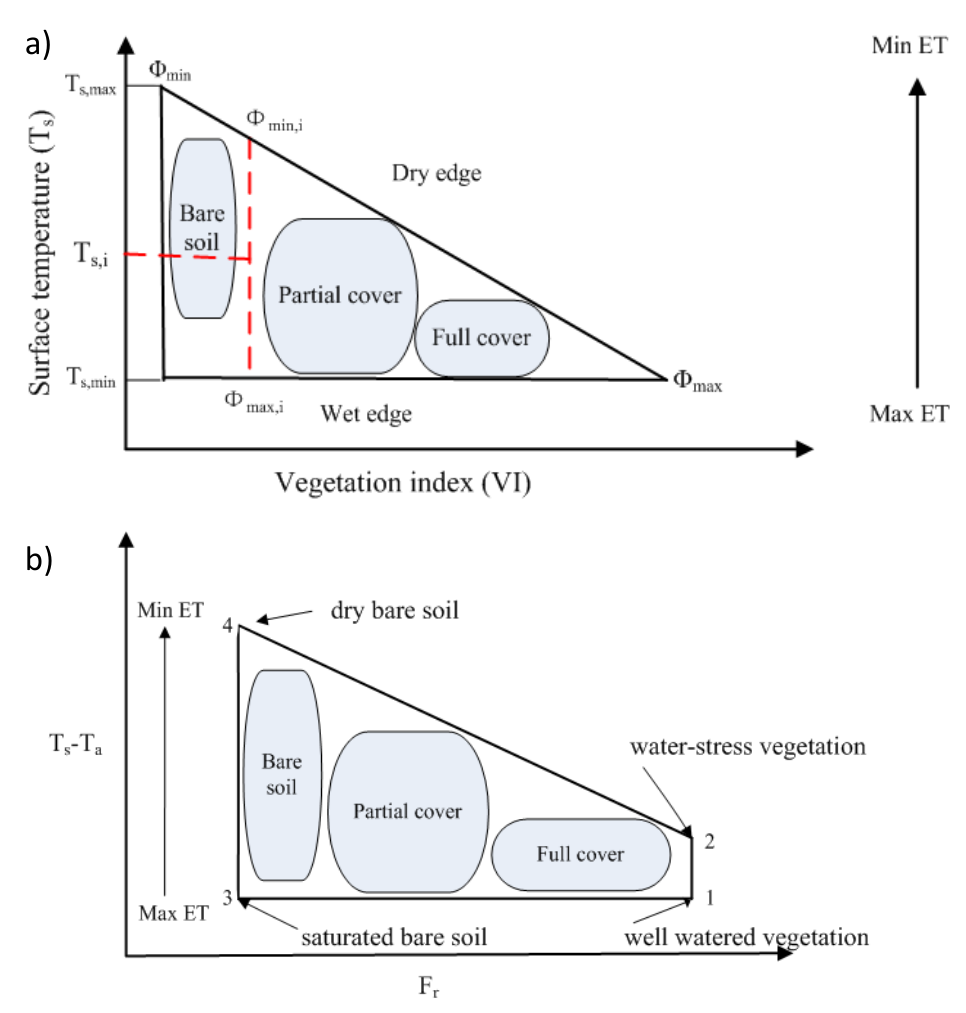
Figure 2. ( a ) Simplified T s − VI triangular diagram. ( b ) ( T s − T a )- FVC trapezoidal space. (Both Figure 2. (a ) Simplified T s -VI triangular diagram. ( b ) ( T s - T a )- FVC trapezoidal space. (Both diagrams extracted from [17]). diagrams extracted from